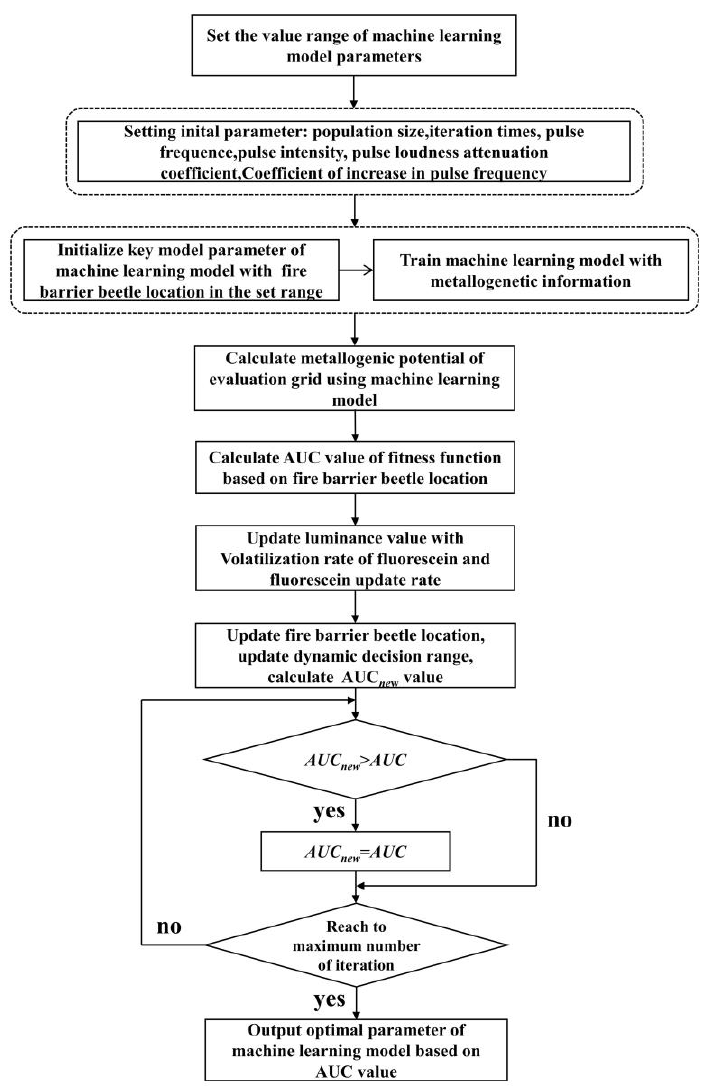
Figure 9. Firefly algorithm (FA) optimization process.